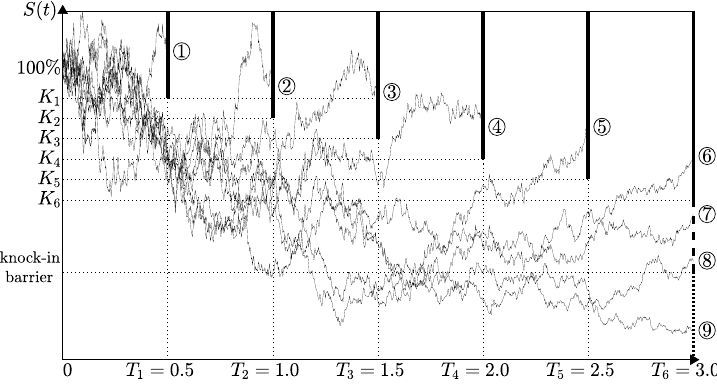
Figure 2. Nine cases of random stock path for the step-down type ELS.